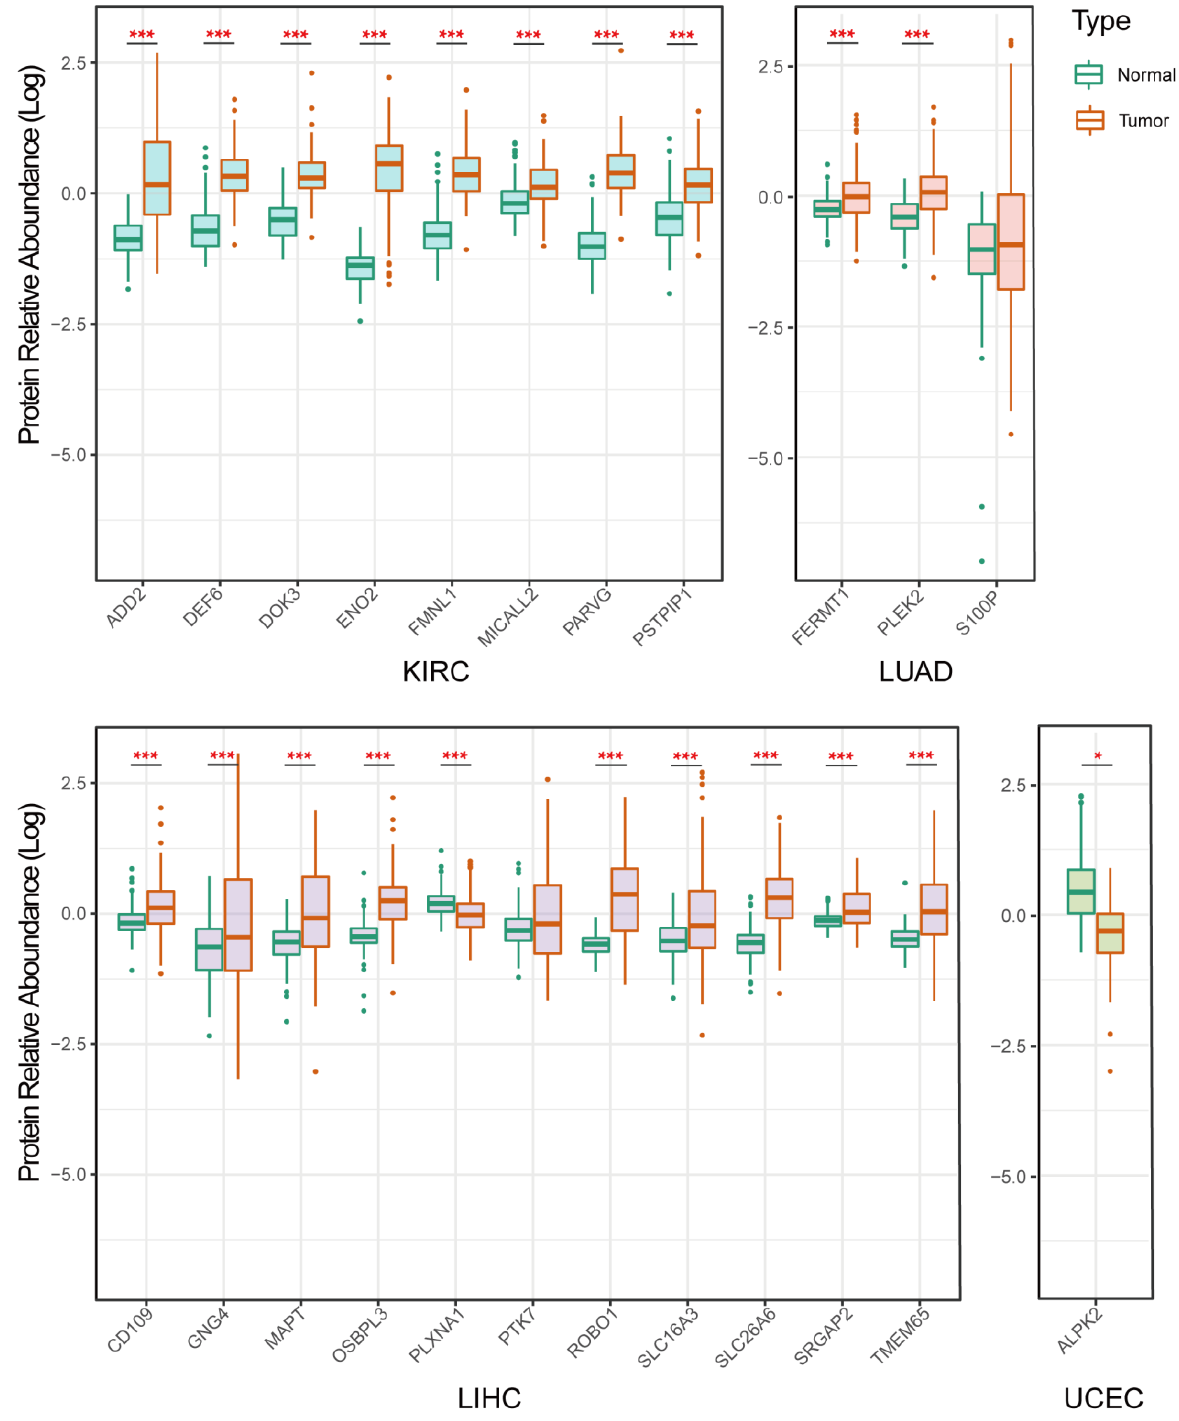
Figure 8. Box plots showing the relative abundance of target membrane proteins in cancer and normal tissues in four tumor types. * means p < 0.05, and *** means p < 0.001.